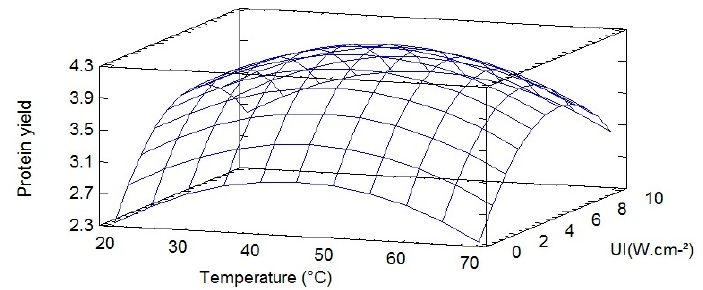
Figure 3. Response Surface Plots for protein yield depending on the temperature and the ultrasound power.